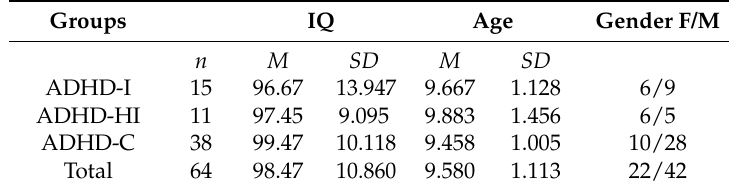
Table 1. Means and Standard Deviations of IQs and Age of the